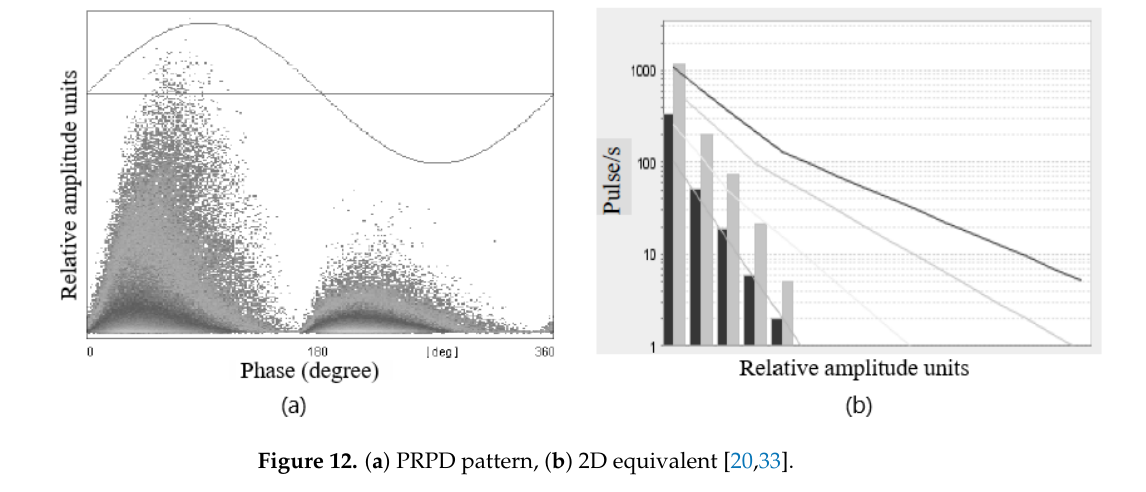
Figure 12. ( a ) PRPD pattern, ( b ) 2D equivalent [20,33].